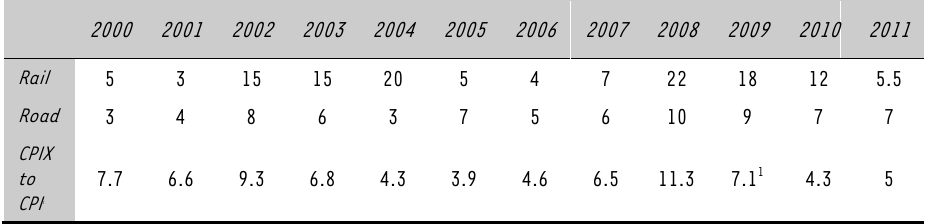
Percentage change in South Africa’s road and rail costs, 2000 to 2011